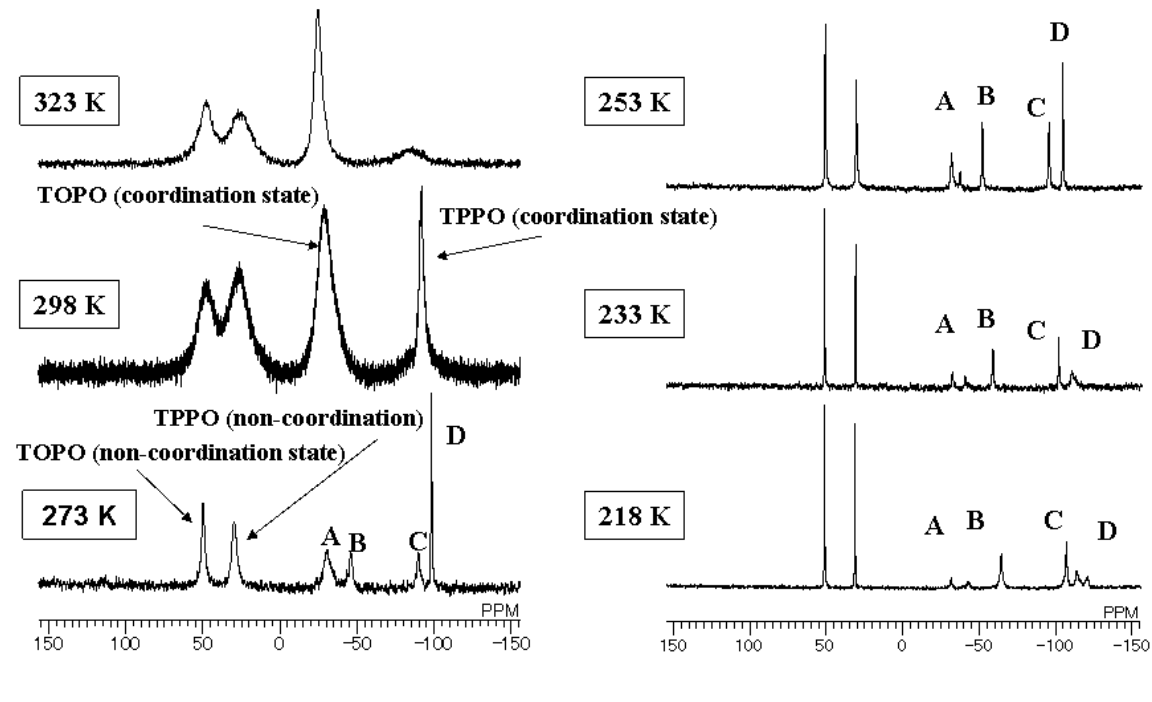
Figure 5. Temperature dependence of 31 P NMR spectra of a mixture of Eu(III) complex